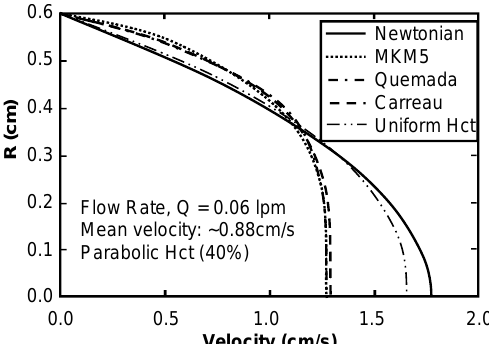
Figure 6. The fully-developed, steady-state velocity profile for Poiseuille flow of 40% hematocrit blood in a tube. Results compare the Newtonian solution (Parabolic), with the Modified Krieger model, the modified Quemada Model, and the model used by Jung et al. at a flow rate of 0.06 lpm ( a ) and 6 lpm ( b ). Fluids 2017 , 2 , 10